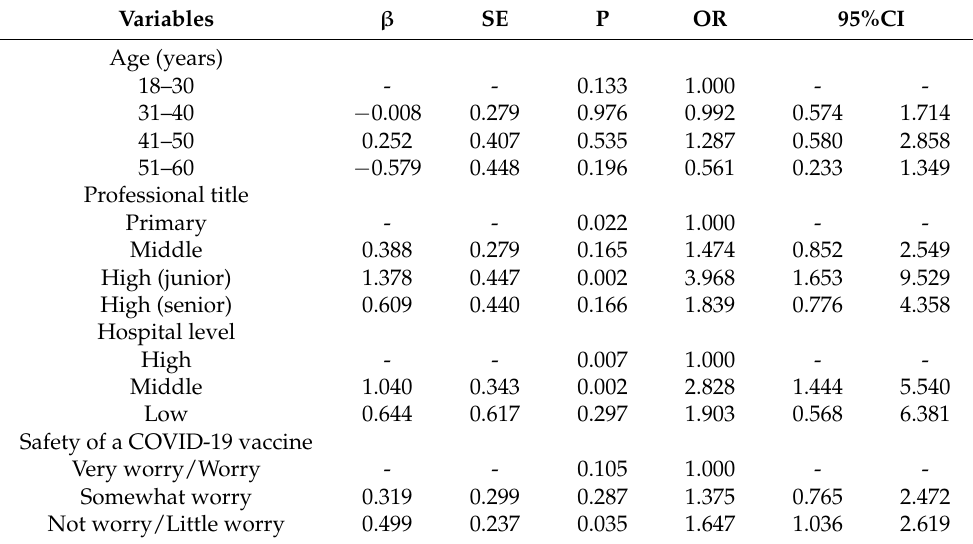
Table 3. Factors associated with COVID-19 vaccine acceptance: Binary logistic regression 1